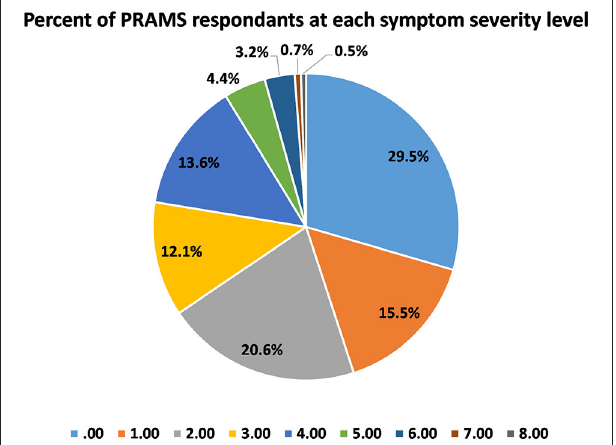
FIGURE 1 | Distribution of symptom severity scores across PRAMS